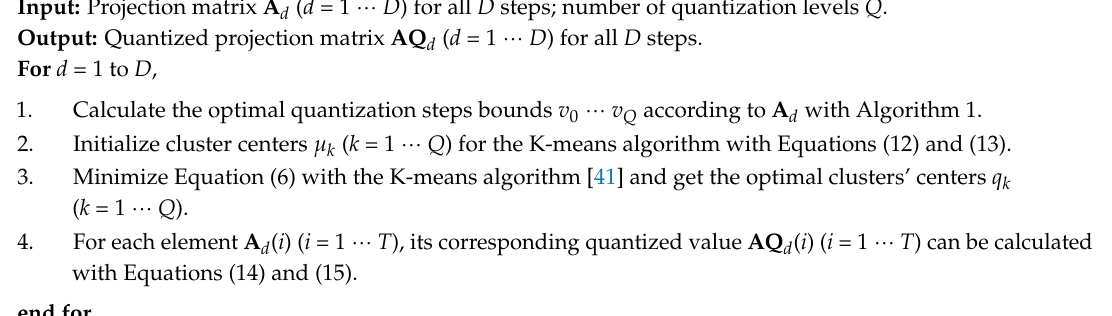
Algorithm 2. The proposed data quantization algorithm.